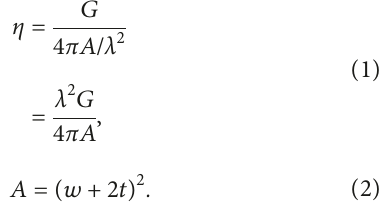
13.5mm, h 4.318mm, (cid:29) (cid:29)